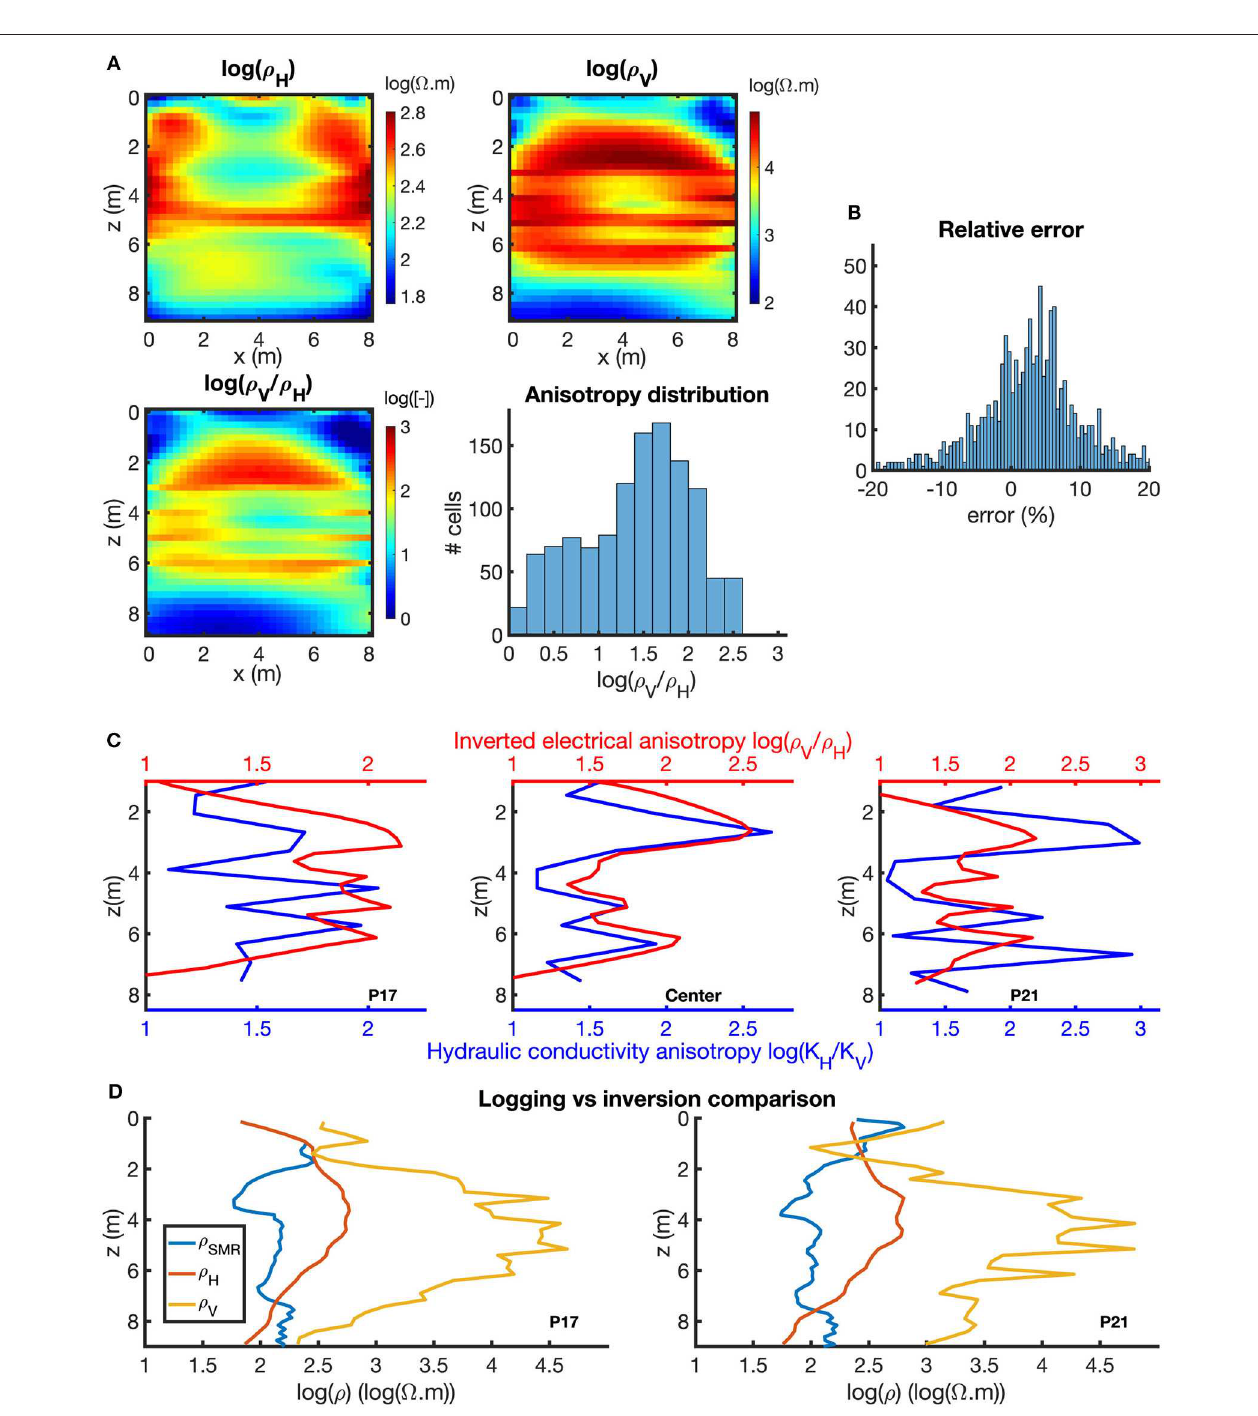
FIGURE 8 | Real case study inversion results displaying logarithmic inverted resistivities. (A) Inverted results from the apparent resistivities acquired between P17 (x = 0 m) and P21 (x 8 m) on the tomography site ( Figure 1 ). (B) Histogram of the relative error between measured and inverted ρ app . (C) Comparison between inverted = hydraulic (blue curves) and electrical (red curves) anisotropies. Hydraulic data starts at z 1 m (saturated depth). To compensate the resolution difference, the inverted = resistivities are averaged on the 2.5 m around the wells and in the center of the modeled section. (D) Comparison between the logged ( ρ SMR , blue curves), and the inverted horizontal ( ρ H , red curves) and vertical ( ρ V , yellow curves) resistivities (corresponding to the P17 and P21 resistivities).